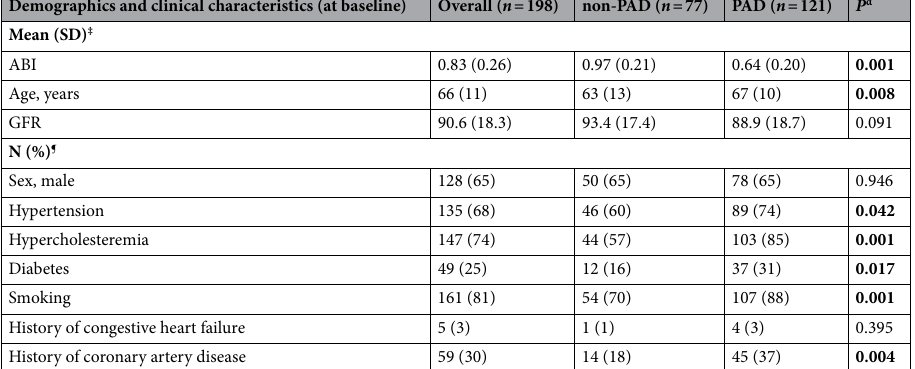
Table 1. Baseline clinical and laboratory characteristics. Frequencies and percentages were calculated for categorical variables; all numbers were rounded up with zero decimal place. All p -values were rounded to three decimal places, p < 0.05 in bold. ABI: Ankle Brachial Index. GFR: Glomerular Filtration Rate. α The significance of the difference between PAD and non-PAD groups. ‡ Compared using student’s t-test. ¶ Compared using chi- square